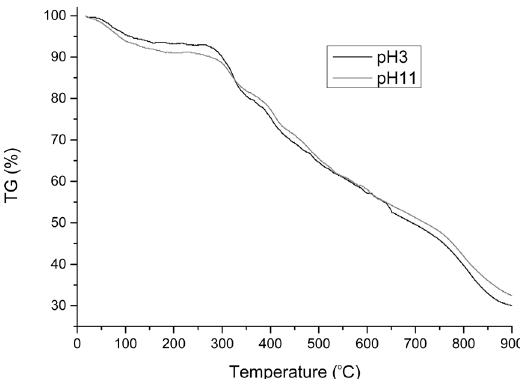
Figure 1. Thermogravimetric curves of precursor powders obtained in basic and acid